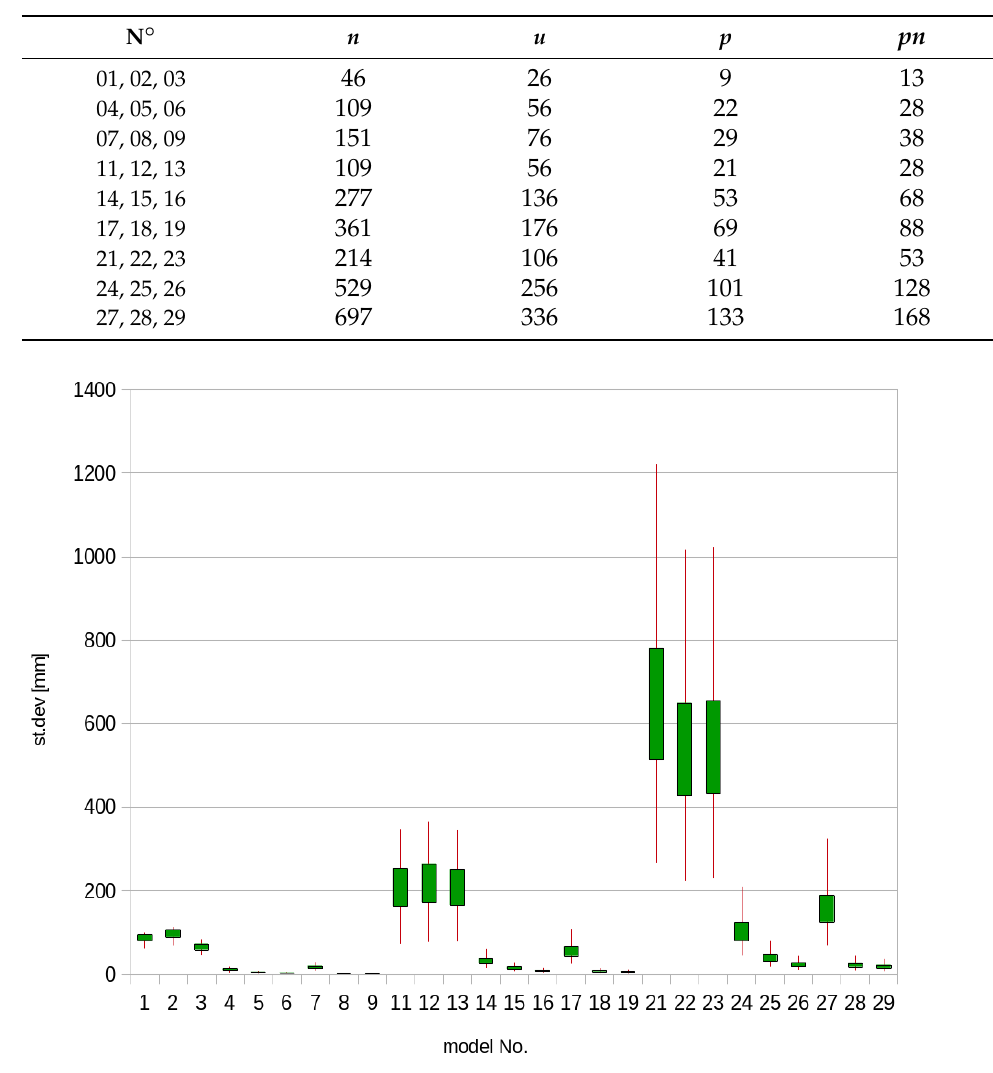
Table 2. Adjustment data.